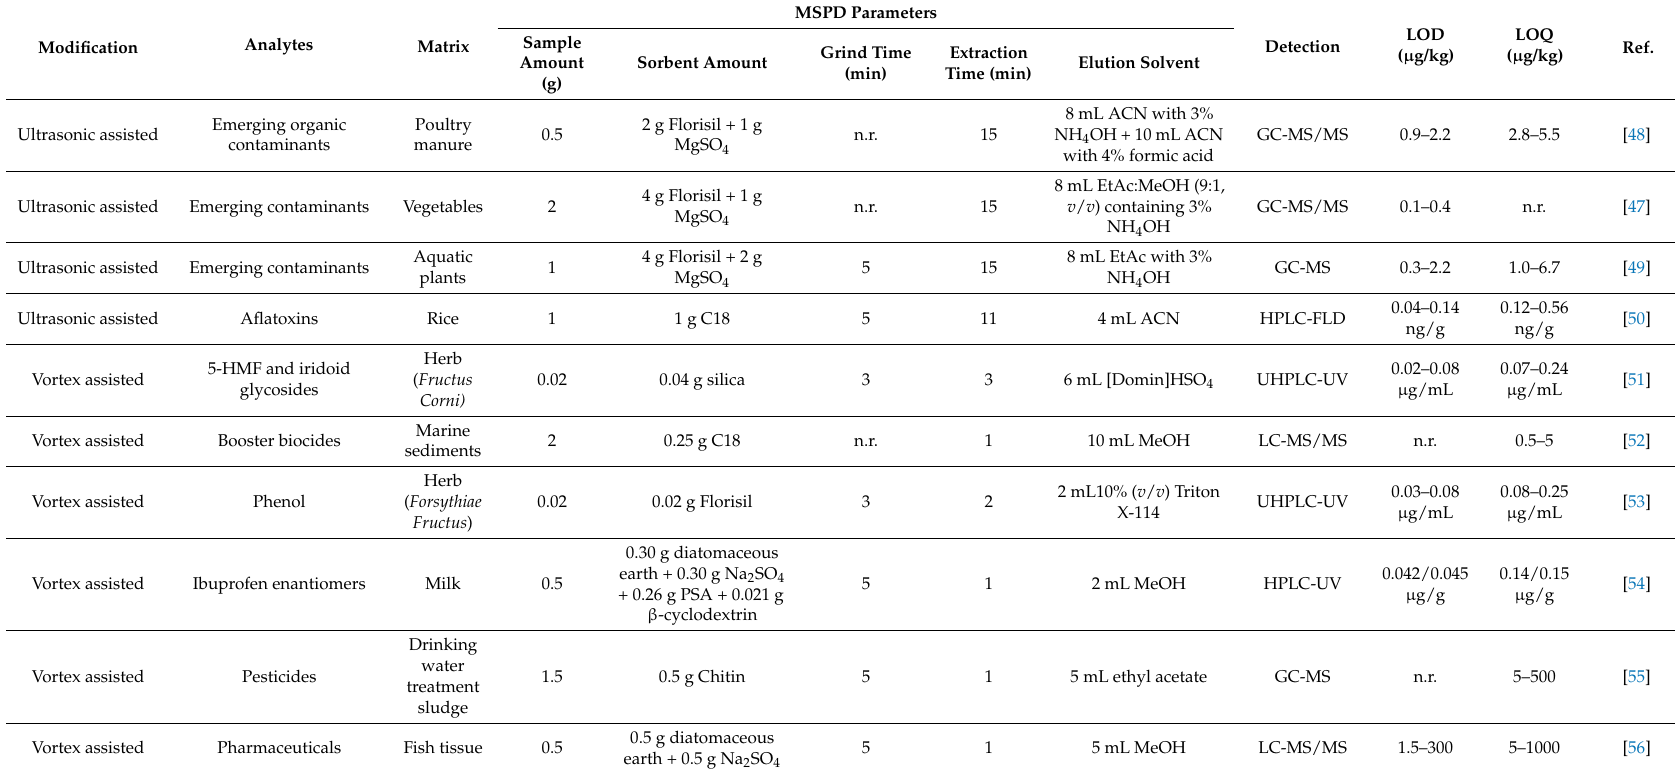
Table 3. Selected representative studies using ultrasonic assisted MSPD and vortex assisted